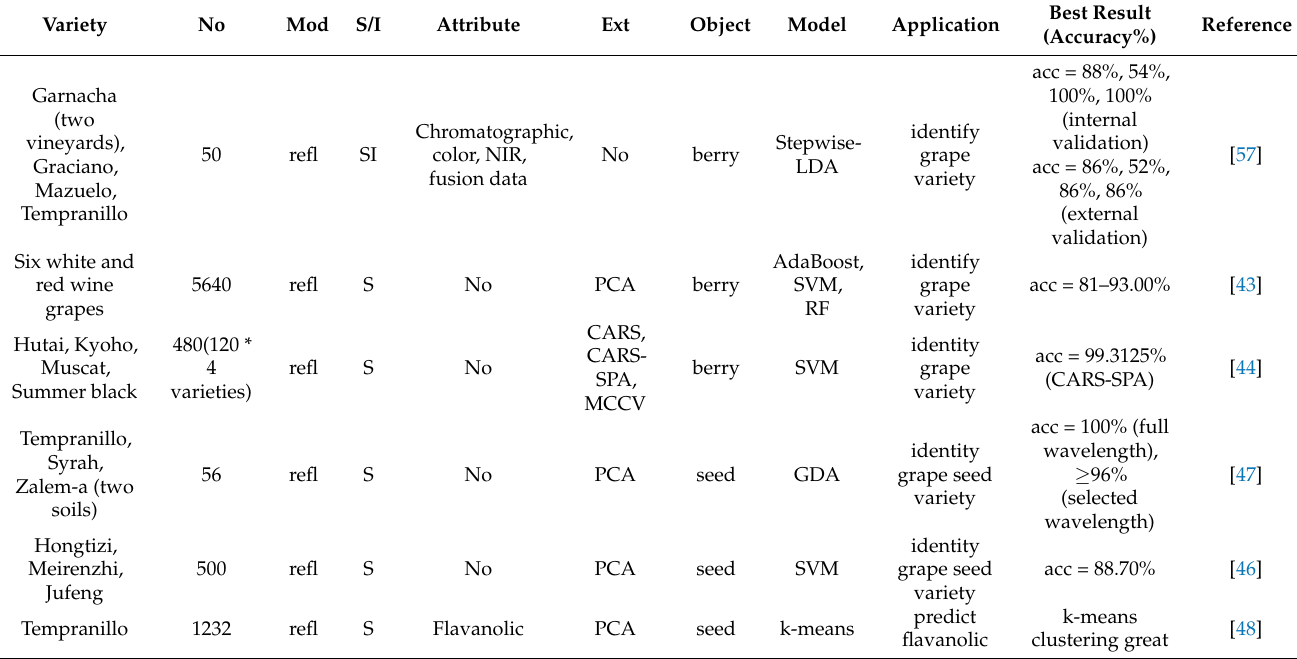
Table 3. Qualitative analysis of hyperspectral imaging (HSI) in grape.